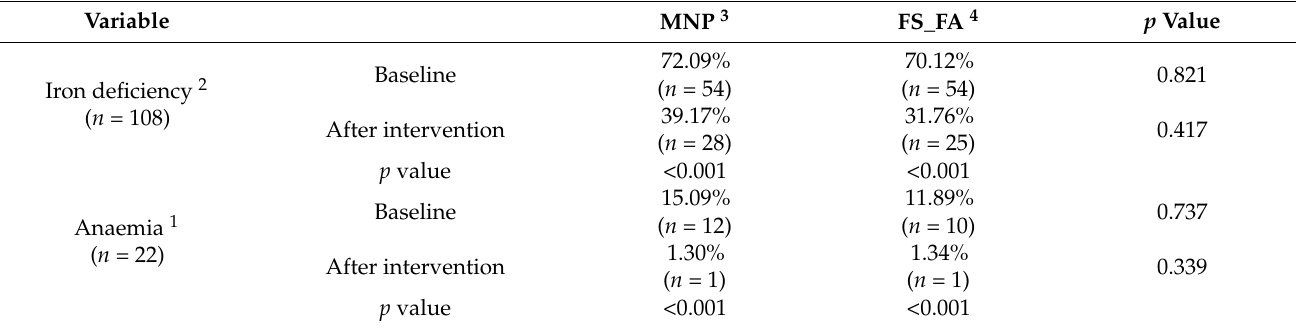
Table 2. Prevalence of anaemia and iron deficiency at baseline and after